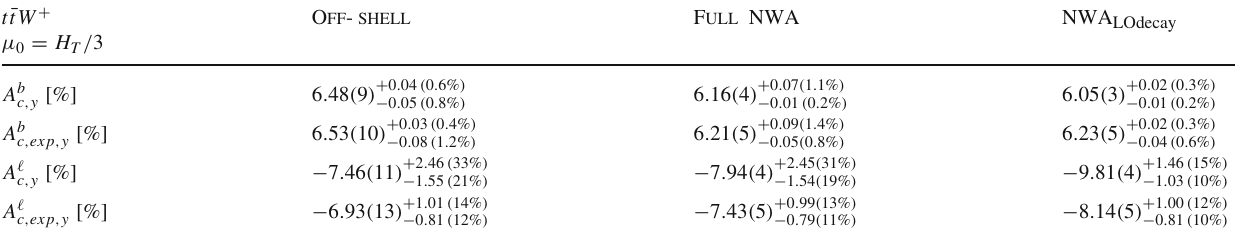
Table 7 Expanded A t c , A (cid:4) c and A b c at NLO in QCD for pp → t ¯ tW + and pp → t ¯ tW − in the multi-lepton channel at the LHC with TeV. Results are obtained with the full off-shell effects included. Also